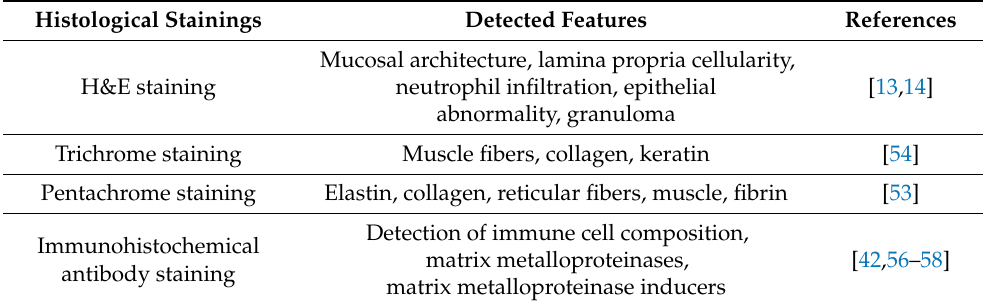
Table 2. Diagnostic histopathological methods to detect inflammation and complications in